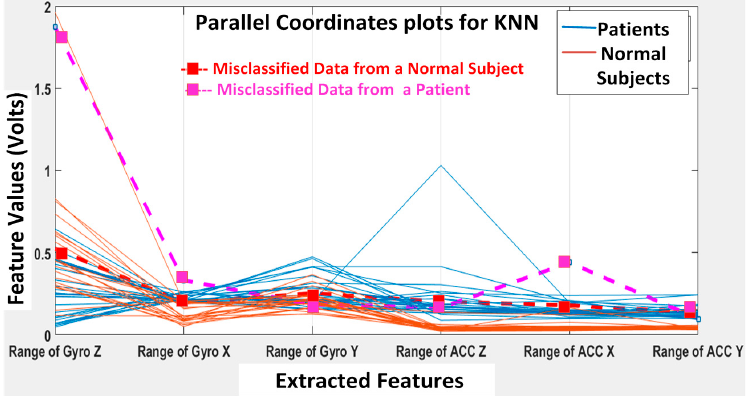
Figure 17. K -nearest neighbor (KNN) classification results: two misclassifications shown in the feature space: Case 7 (DGI 7) of the first normal subject and Case 1 (DGI 1) of the second patient classified as patient and normal subject, respectively.